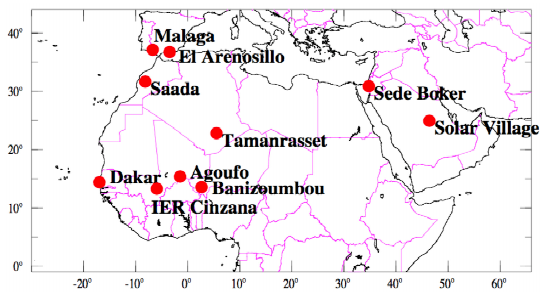
Figure 7. Localization map of the 10 AERONET sites used in the AOD training.